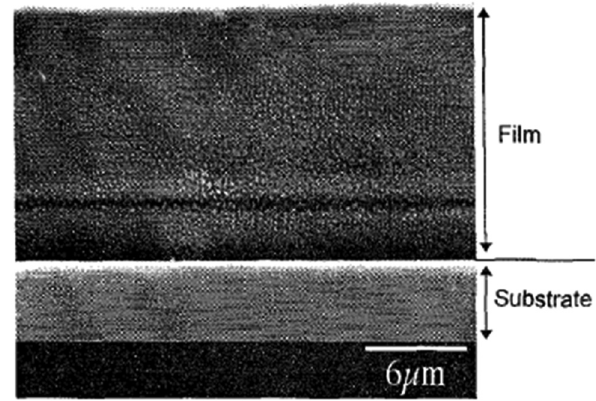
Figure 6: Cross - sectional SEM image of a stain - etched Si fi lm depos - ited on single crystalline Si in molten LiF – KF containing 10wt% K 2 SiF 6 at 1,123K [ 108 ] . Permission from